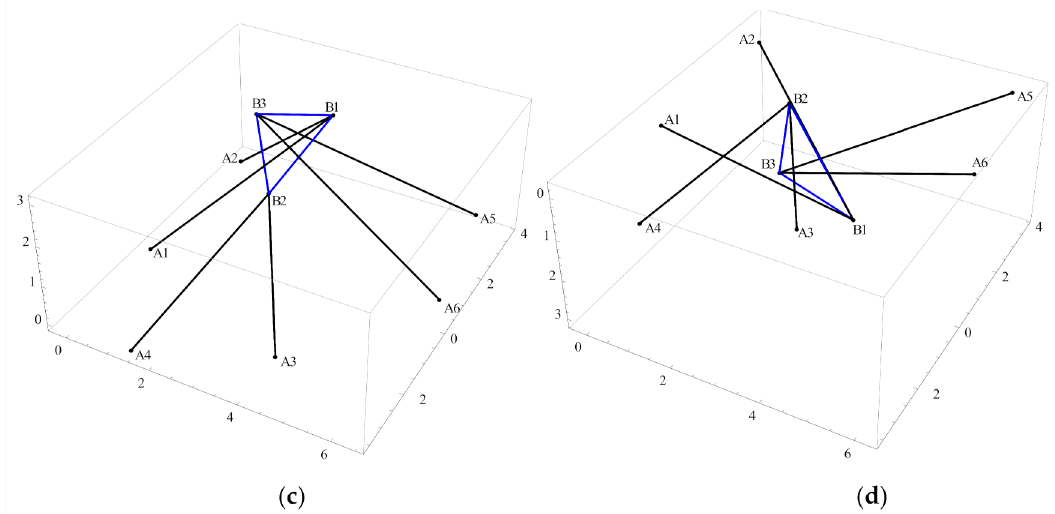
Figure 3. Four assembly configurations ( a , b , c , d ) of 6-3 Stewart